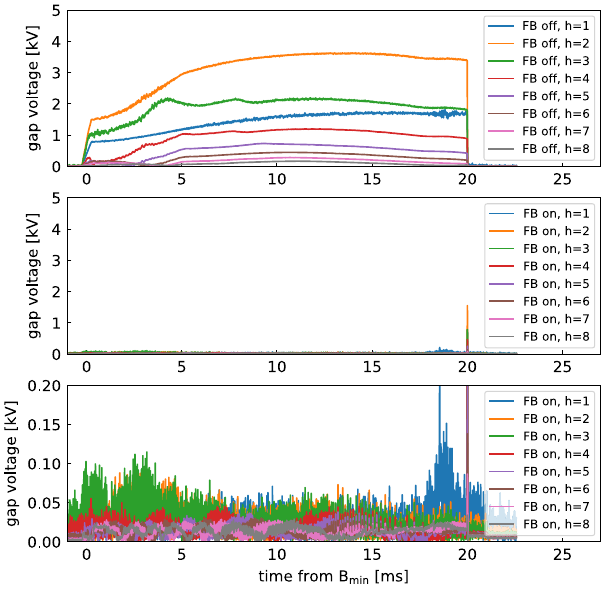
FIG. 29. Harmonic components of the gap voltage during acceleration of two bunches (top) without feedback and (middle) with feedback and (bottom) a vertically magnified view of the middle plot.